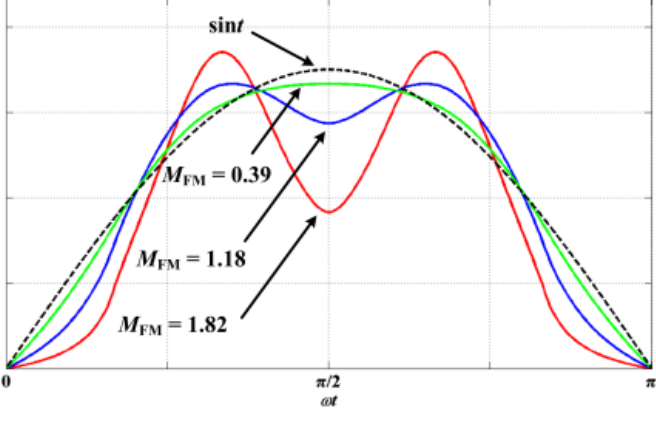
Figure 14. Influence on the input current by M FM .